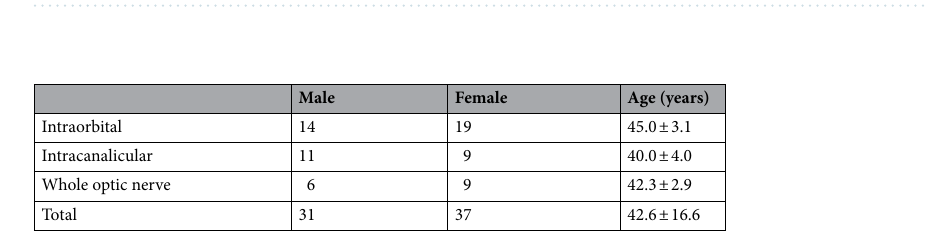
Figure 1. Location of abnormal findings on MRI. ( A ) intraorbital lesion, ( B ) intracanalicular area, ( C ) whole optic nerve involvement (optic nerve to canal).